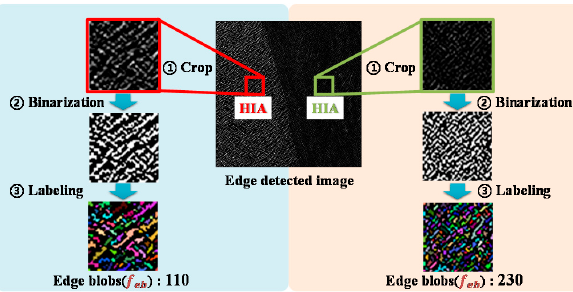
Figure 5. Examples of determining the carrier frequency.